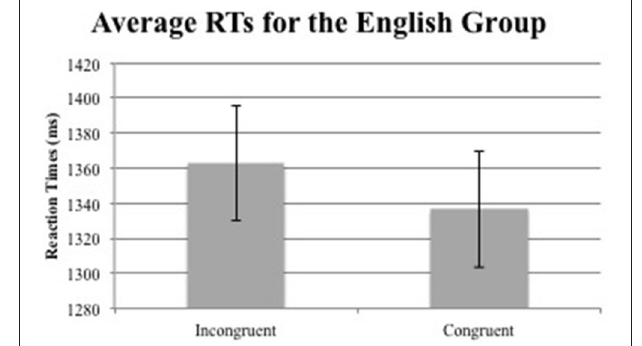
FIGURE 4 | Average RTs for the English group (error bars indicate 1 standard error above and below the mean).